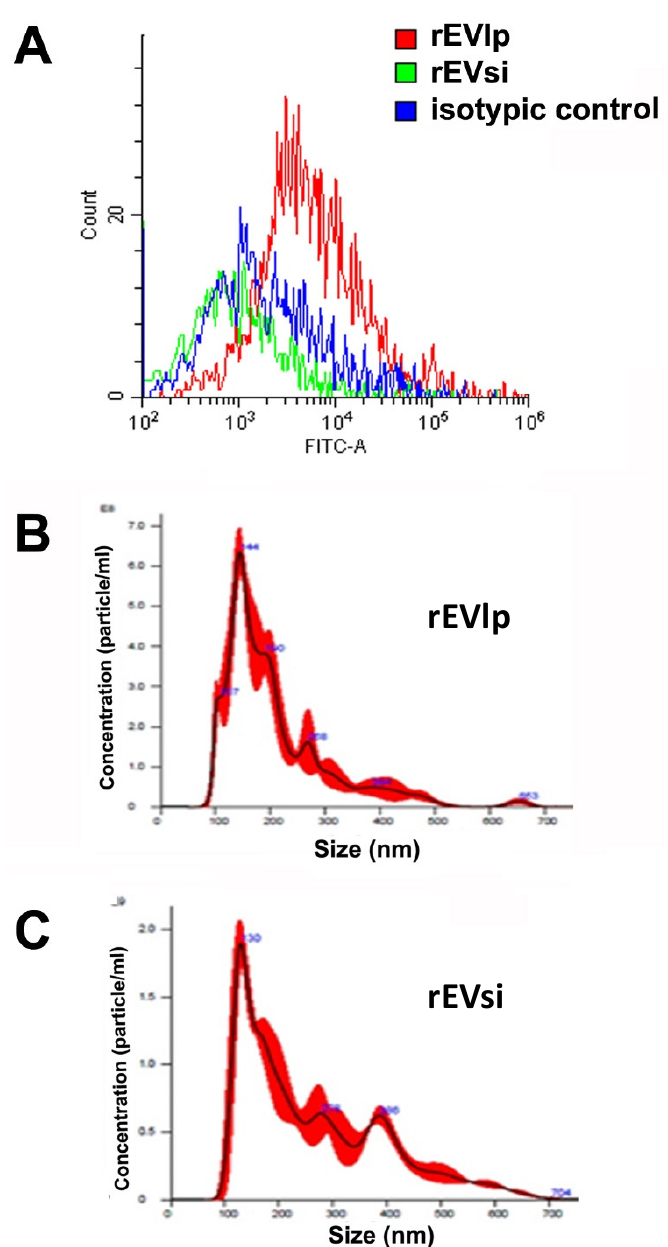
Figure 2. Characterization of rat extracellular vesicles (EVs). ( A ) Representative cytofluorimetric analyses of EVs obtained from rat mesenchymal stromal cells (rMSCs) transfected in the presence (rEVsi) or absence (rEVlp) of a CD73-specific small interfering RNA (siRNA) (n = 3 samples analyzed with similar results). The red line represents the fluorescence intensity of rEVlp incubated with an anti-CD73 antibody. The blue line represents the fluorescence intensity of rEVs obtained from CD73-silenced MSCs (rEVsi). The green line is the isotypic control. ( B , C ) Representative graphs of nanoparticle tracking analysis showing the size distribution of ( B ) rEVlp and ( C ) rEVsi (n = 3 samples analyzed with similar results).